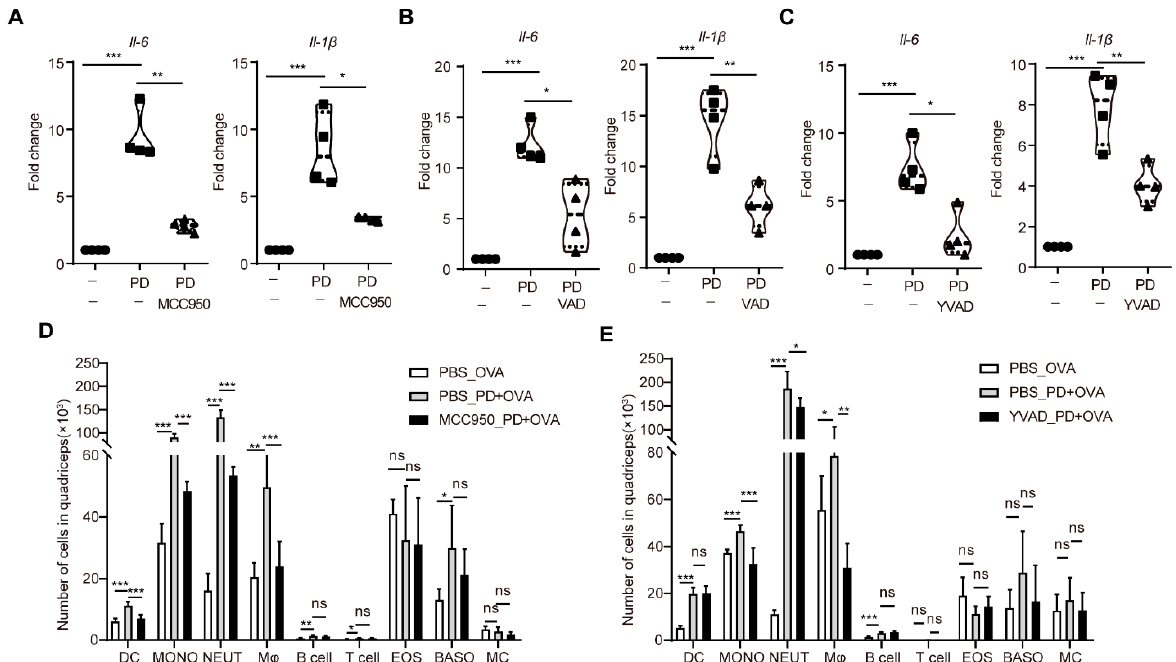
Figure 7. The NLRP3 inflammasome–caspase-1 pathway mediated the inflammatory response and immune cell recruitment induced by PD at the injection site. ( A – C ) Mice were injected i.m. with MCC950 (( A ), 3 mg/kg, 30 min), z-VAD-FMK (( B ), 1 mg/kg, 1 h), or Ac-YVAD-CMK (( C ), 1 mg/kg, 1 h), and with PD (50 μ g) in the quadricep muscles at the indicated time interval. After 2 h, the quadricep muscle tissues were collected and assayed for the gene expression levels of Il-6 and Il-1 β by RT-qPCR. ( D , E ) Mice were injected i.m. with MCC950 (( D ), 3 mg/kg, 30 min) or Ac-YVAD-CMK (( E ), 1 mg/kg, 1 h), and with PD (50 μ g) in the quadricep muscles at the indicated time interval. After 24 h, the quadricep muscle tissues were collected and assayed for the number of various immune cells. Data were presented as mean ± SD ( n = 3). (*) p < 0.05, (**) p < 0.01, (***) p < 0.001, ns not significant. DC, dendritic cell; MONO, monocyte; NEUT, neutrophil; M φ , macrophage; EOS, eosinophil; BASO, basophil; MC, mast cell.